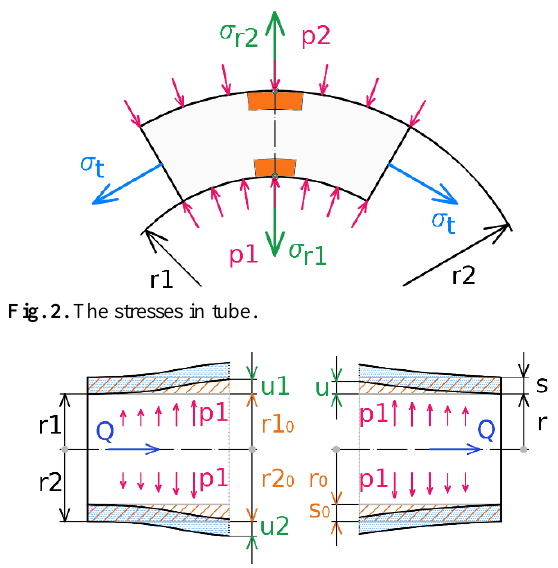
Fig. 3. Loading, dimensions and deformations of the tube